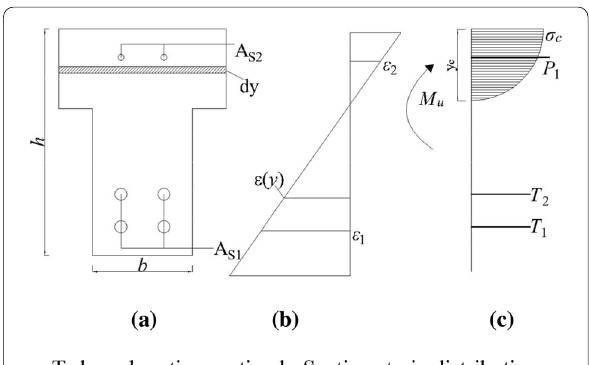
Fig.5 Section bending analysis. A s1 represents the total area of the tension bars and A s2 is the total area of the compression bars. Moreover, ε represents the section strain which is a function of the ordinate. Furthermore, T 1 , T 2, and P 1, respectively, represents the resultant force of the first-row tension bars, that of the second-row tension bars, and that of the compressed steel bars. What is more,